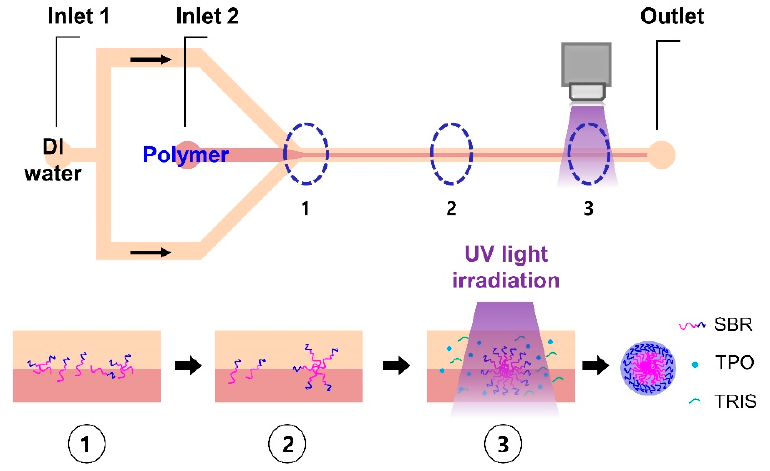
Figure 2. Schematic diagram of experiment to fabricate HPNCs: ① Dispersion and nucleation; ② Growth through aggregation; ③ Self-assembly and photo-crosslinking.